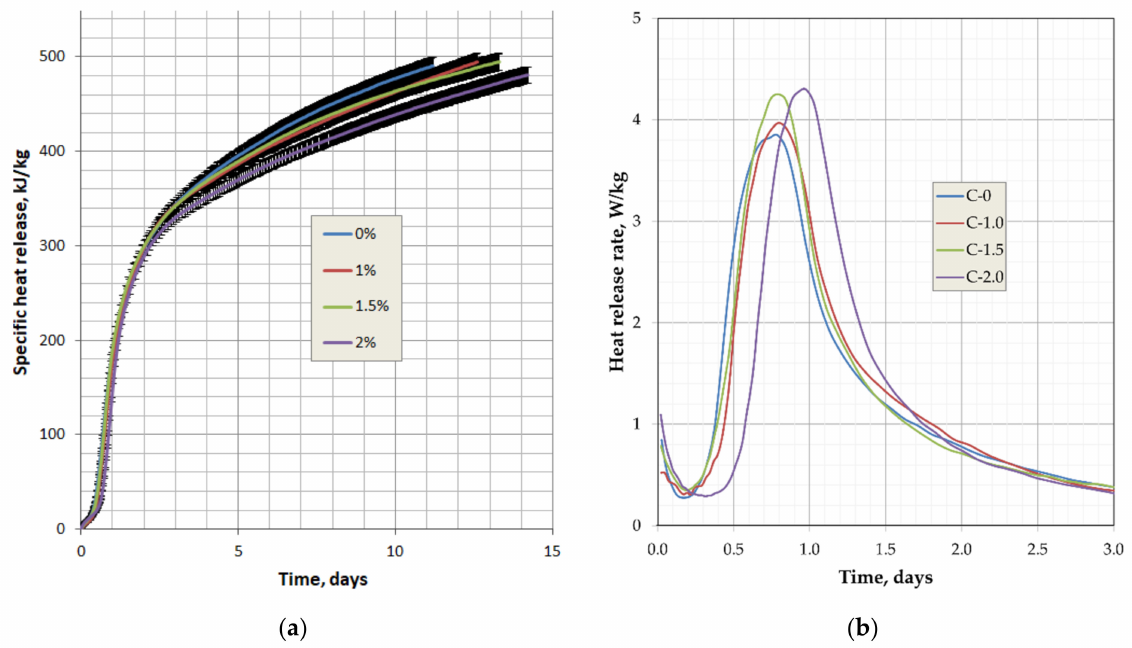
Figure 11. Influence of Pro-Flowstab additive: ( a ) on the integral value; ( b ) rate of the specific heat flow of cement in